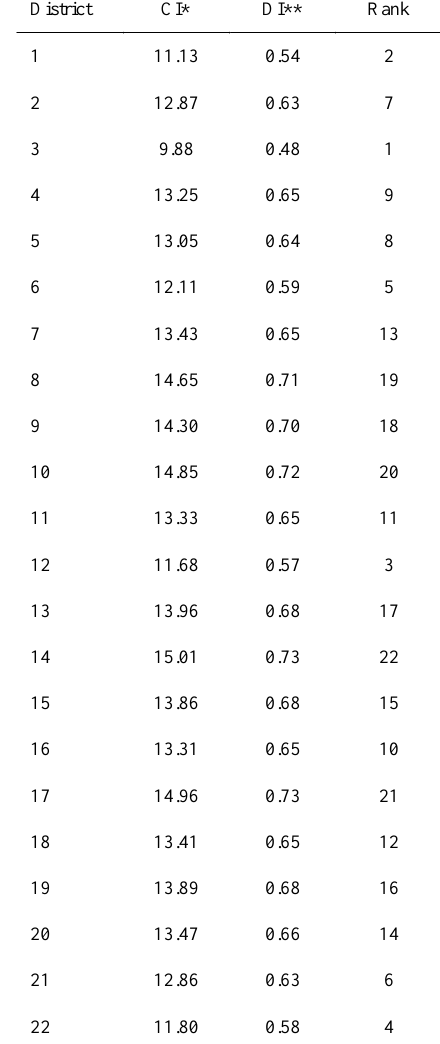
Table 5: The distribution of services in the districts of Tehran based on numerical taxonomy